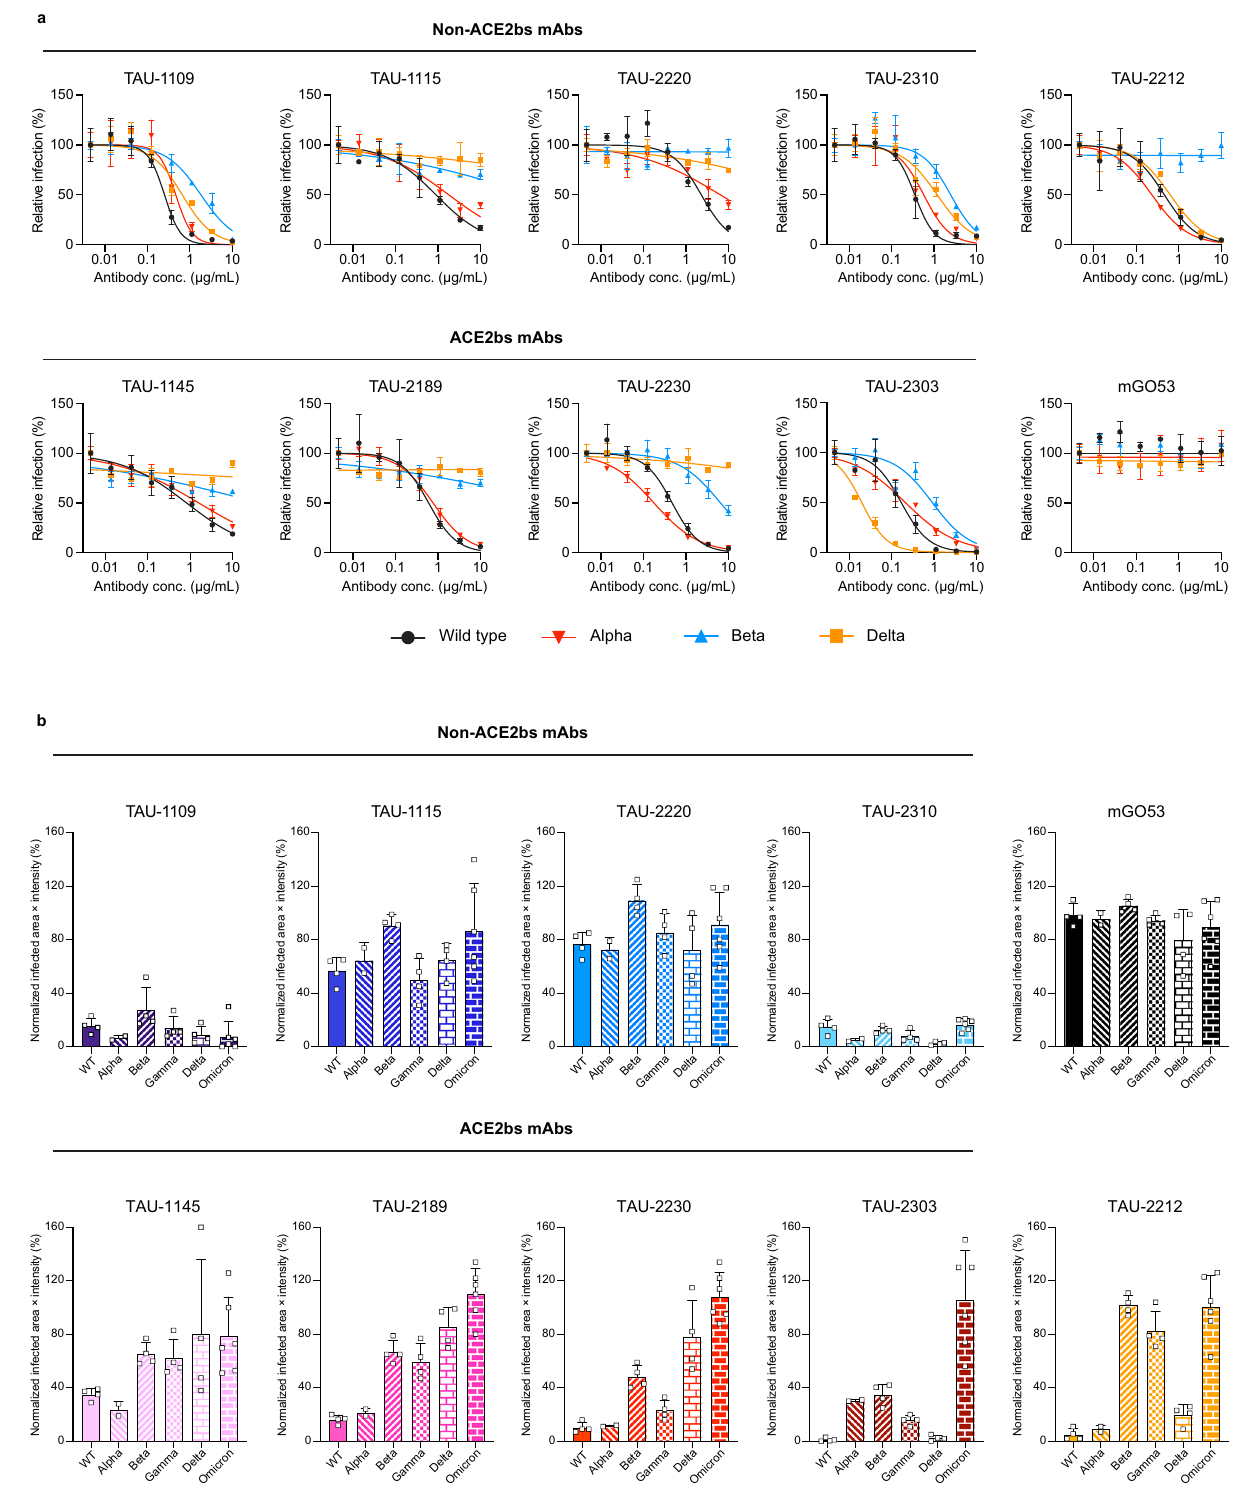
Fig. 3 Antibody neutralization of wild type and VOCs. a Antibody neutralization curves of wild type, Alpha, Beta, and Delta VOC pseudo-typed GFP reporter viral particles. For every mAb, each curve represents inhibition of one VOC as indicated. Antibodies were pre-incubated with viral particles at 8 consecutive 3-fold dilutions starting at 10 µ g/mL of antibody. Fluorescence of infected cells was read 72h post infection. Inhibition percentage was calculated by normalizing to untreated cells. Each experiment was done in triplicate ( n = 3). mGO53 was used as an isotype control. Error bars indicate SD. b Infection of Vero-TMPRSS2 cells by wild type ( n = 4), Alpha ( n = 2), Beta ( n = 4), Gamma ( n = 4), Delta and Omicron ( n = 6) with authentic SARS-CoV-2 and overlayed with carboxymethylcellulose. Values are expressed as the infected surface area of cells and normalized to infected cells without mAb. Viral particles were pre- incubated with 100 µ g/mL of antibody for 1 h before addition to the cells. Infected cells were identi fi ed at 24h post infection using SARS-CoV-2 nucleocapsid antibody after cell fi xation and permeabilization. Infected cells were quanti fi ed using Incucyte S3. mGO53 serves as an isotype control. Error bars indicate SD.